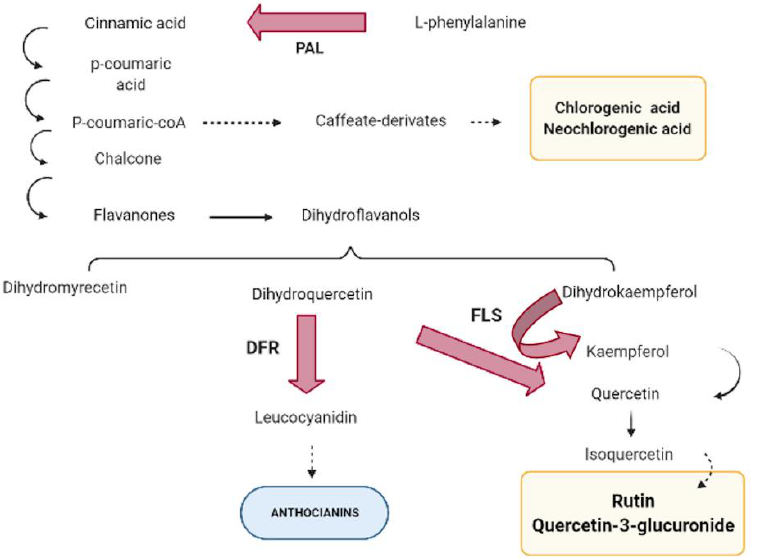
Figure 1. Phenolic biosynthesis pathway. Red arrows represent the key genes studied: PAL (phenylalanine ammonia-lyase), FLS (flavonol synthase), and DFR (dihydroflavonol-4-reductase). Yellow squares represent the main metabolites contributing to apricot antioxidant capacity.